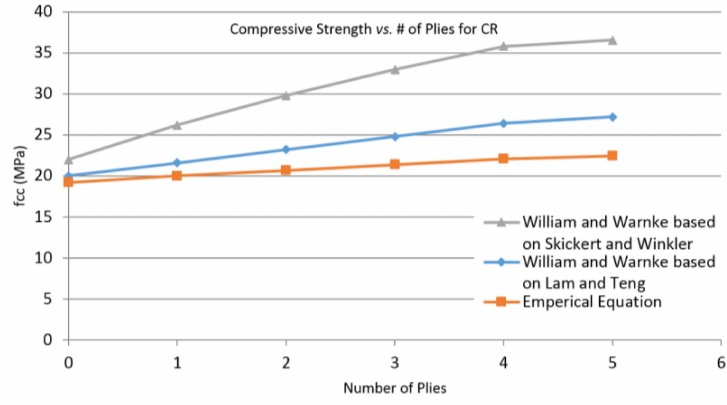
Figure 12. Updated compressive strength vs. number of plies for specimen